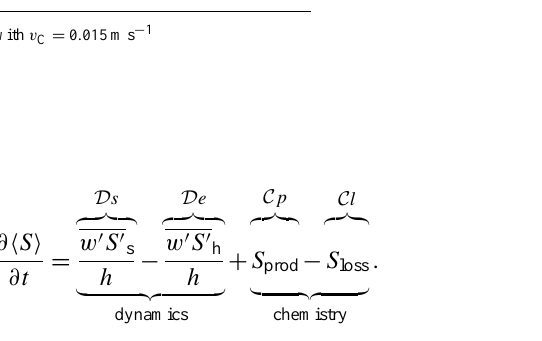
Table 4. Initial mixing ratio in both MOZART and the reduced scheme in the mixed-layer ( h S i ) and free troposphere ( S FT ), and surface emission or deposition. All other species except for molecular oxygen and nitrogen are initialized at zero. The chemistry scheme is initialized at 07:00UTC, t is the elapsed time since the start of the simulation and t d is the time in seconds between 07:00–17:00UTC. O 3 NO NO 2 CH 4 ISO CO H 2 O 2 h S i [ ppb ] 31 0 0.6 1724 0 105 0.1 S FT [ ppb